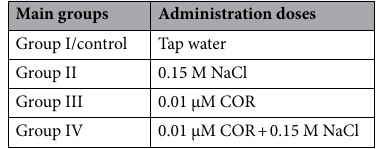
Table 1. Main groups and administration